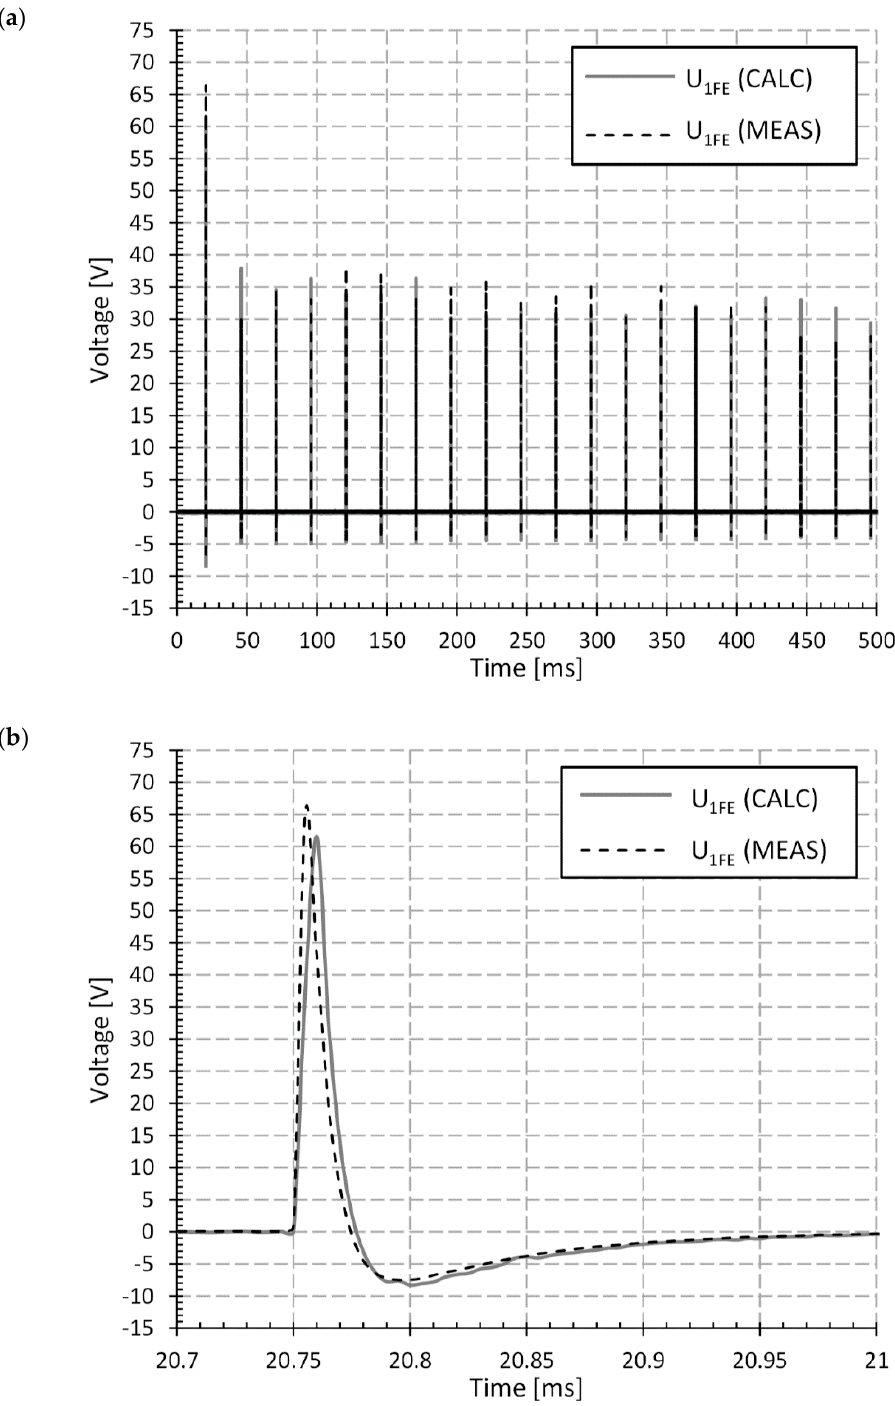
Figure 12. The comparison of measured and calculated voltage of wire 1 at far-end: ( a ) full time scale, ( b ) view of the first stroke.